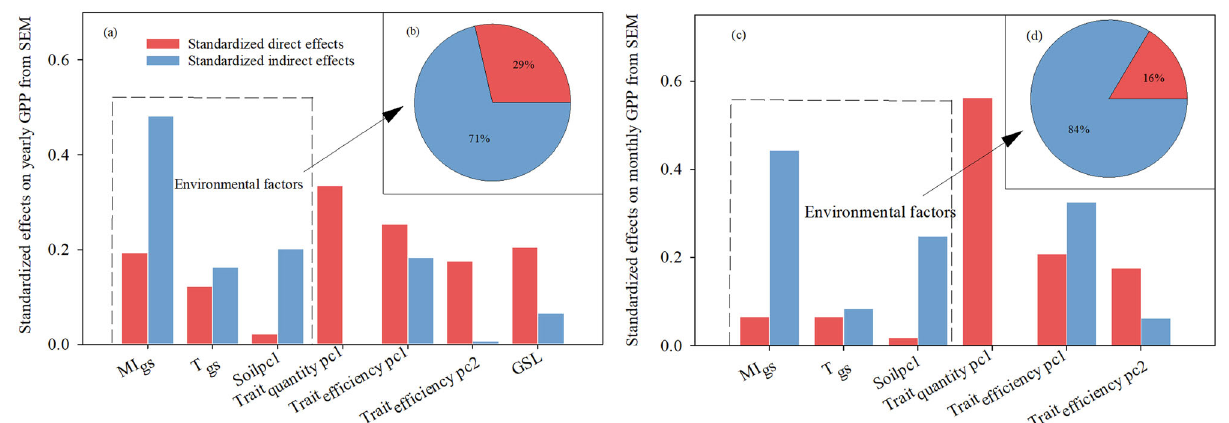
Fig. 4 Standardized direct and indirect effects of environmental factors and traits on gross primary productivity (GPP) across all sites. Panels a and b represent the effect on yearly GPP; c and d represent the effect on monthly GPP; Panels b and d also additionally represent the ratio of direct and indirect effects of environmental factors on GPP. PC 1 and PC 2: fi rst two principal components (PCs) of the corresponding variables; Trait quantity and Trait ef fi ciency : quantity and ef fi ciency traits, respectively; GSL: length of the growing season (months). MI gs and T gs : growing season moisture index and temperature, respectively.